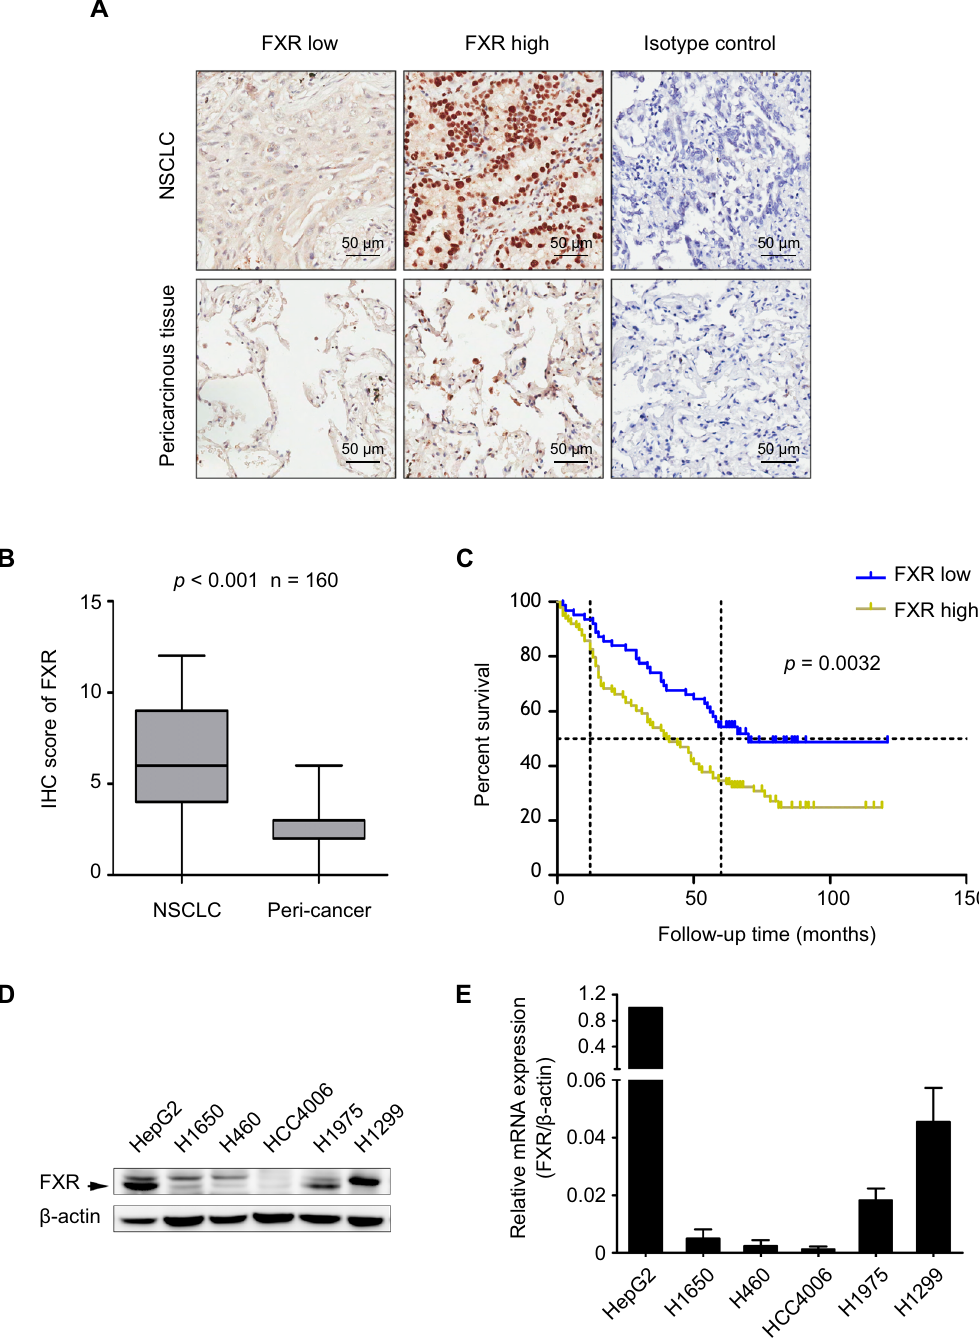
Figure 1. FXR is upregulated in NSCLC and predicts poor outcomes for patients. IHC was performed in 160 pairs of NSCLC and matched normal lung tissues. ( A ) Representative images of FXR high or low expression in NSCLC tissues (upper panel), and images of FXR expression in corresponding pericarcinous lung tissues (lower panel) are shown. Isotype control: the primary antibody was replaced by nonspecific rabbit IgG. ( B ) IHC score of FXR in these paired samples ( p < 0.001). ( C ) Kaplan-Meier analysis of 160 NSCLC patients showing that “FXR high” patients (n = 98) have a shorter OS than “FXR low” patients (n = 62) ( p = 0.0032). HepG2 and five NSCLC cell lines were lysed and collected. ( D ) Western blot was performed to evaluate the FXR protein expression. The band for FXR was indicated by an arrow. ( E ) Quantitative RT-PCR analysis of FXR mRNA expression in these cell lines. In HepG2, the expression level of FXR mRNA was set at 1. All experiments were repeated at least three times. β -actin was used as an internal